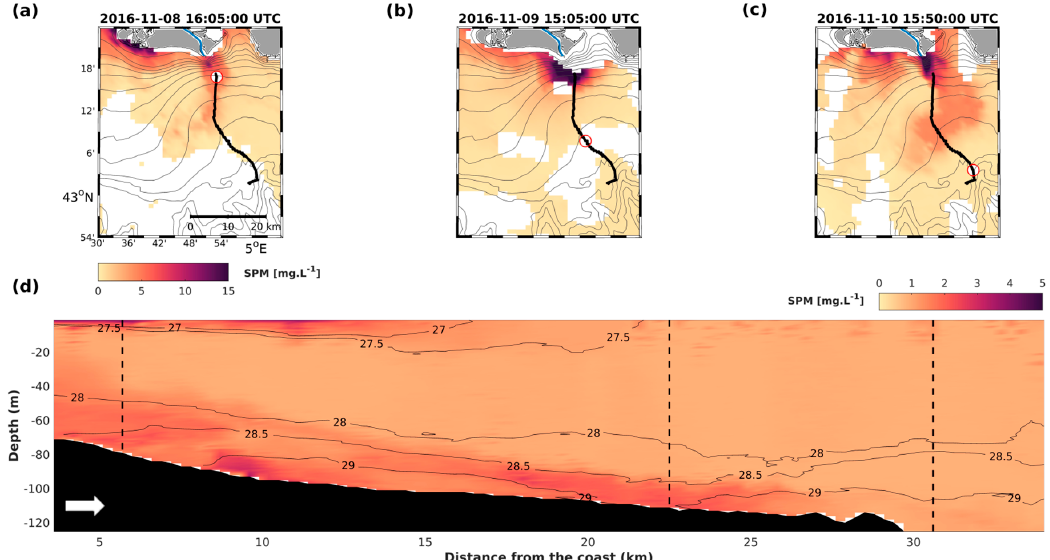
Figure 14. ( a – c ) Surface turbidity from MODIS images, for the glider’s Section 1 in November 2016. Clouds and land are shown as white patches and gray areas, respectively. ( d ) Glider turbidity observations in the water column along the cross-shelf track. The black line indicated the glider’s path and the white arrow shows its direction. The glider’s location at the time the satellite image was taken is shown by the red circle and by dashed black lines in the upper and lower panels, respectively.